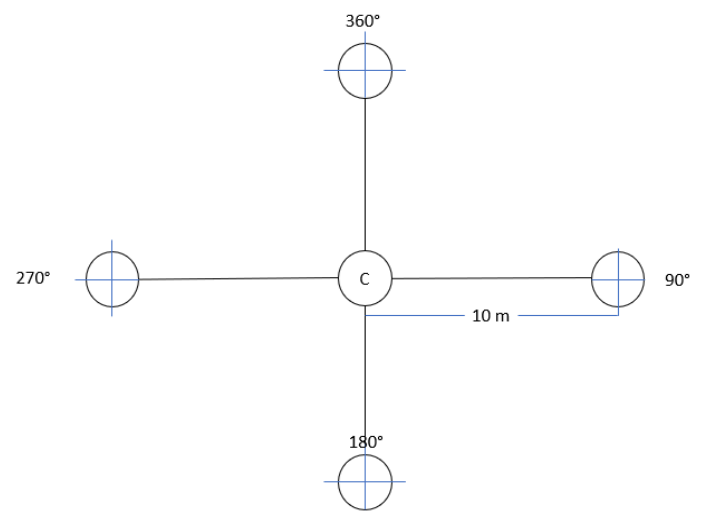
Figure 3. Illustration of sampling plot with composite subplots in different directions from the cen- ter.